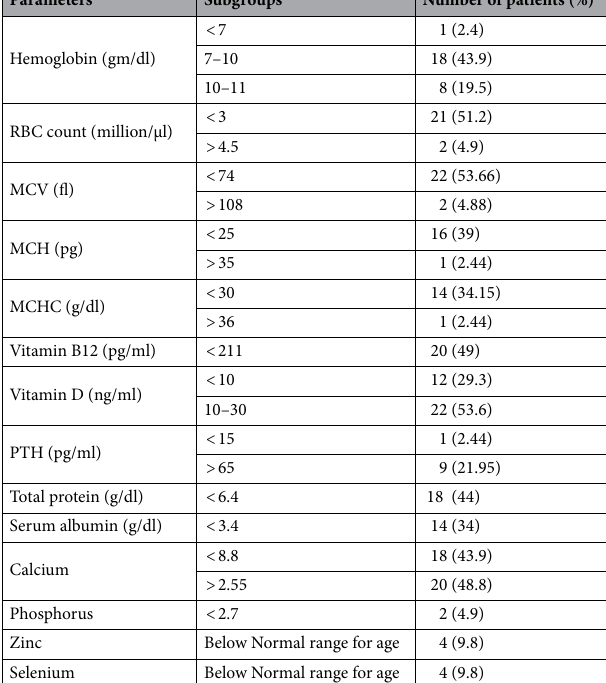
Table 3. Laboratory findings of patients in the study